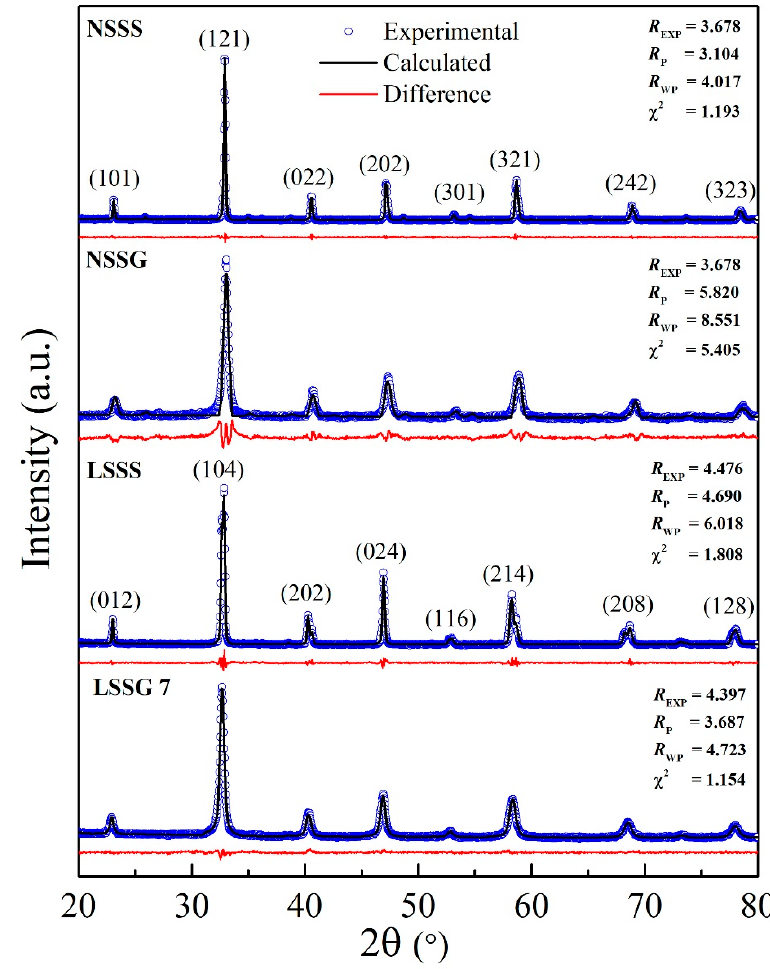
Figure 1. Rietveld refinement of the XRD patterns from LSSG, LSSS, NSSG, and